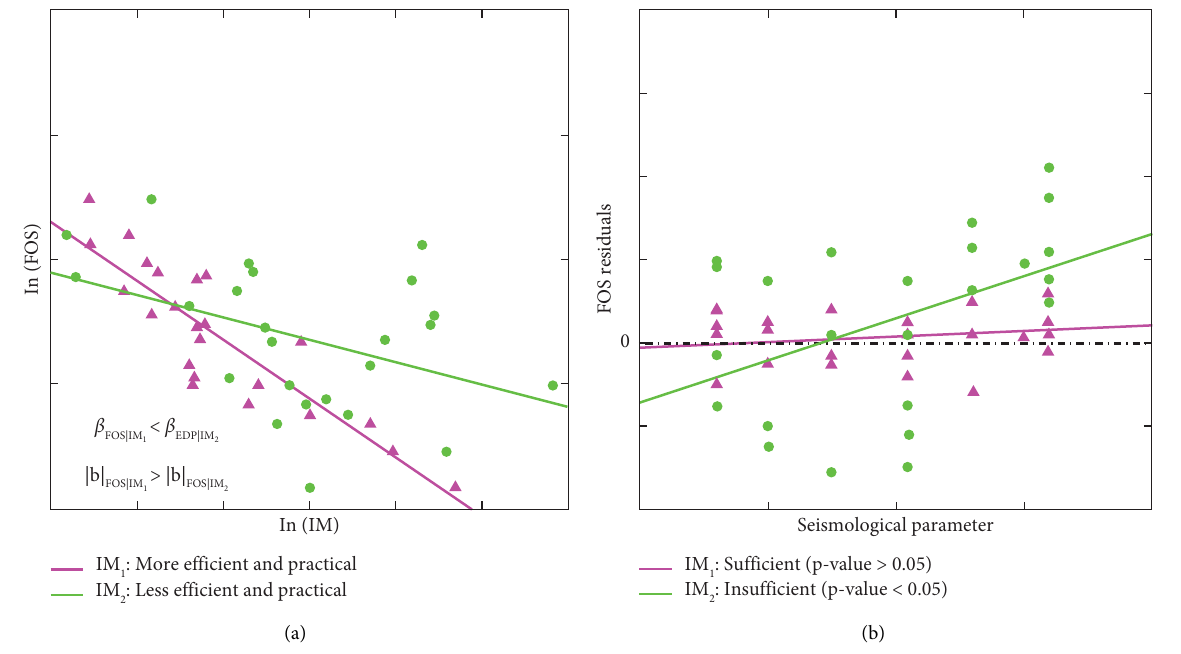
Figure 2: Illustration of (a) IM efciency and practical and (b) IM